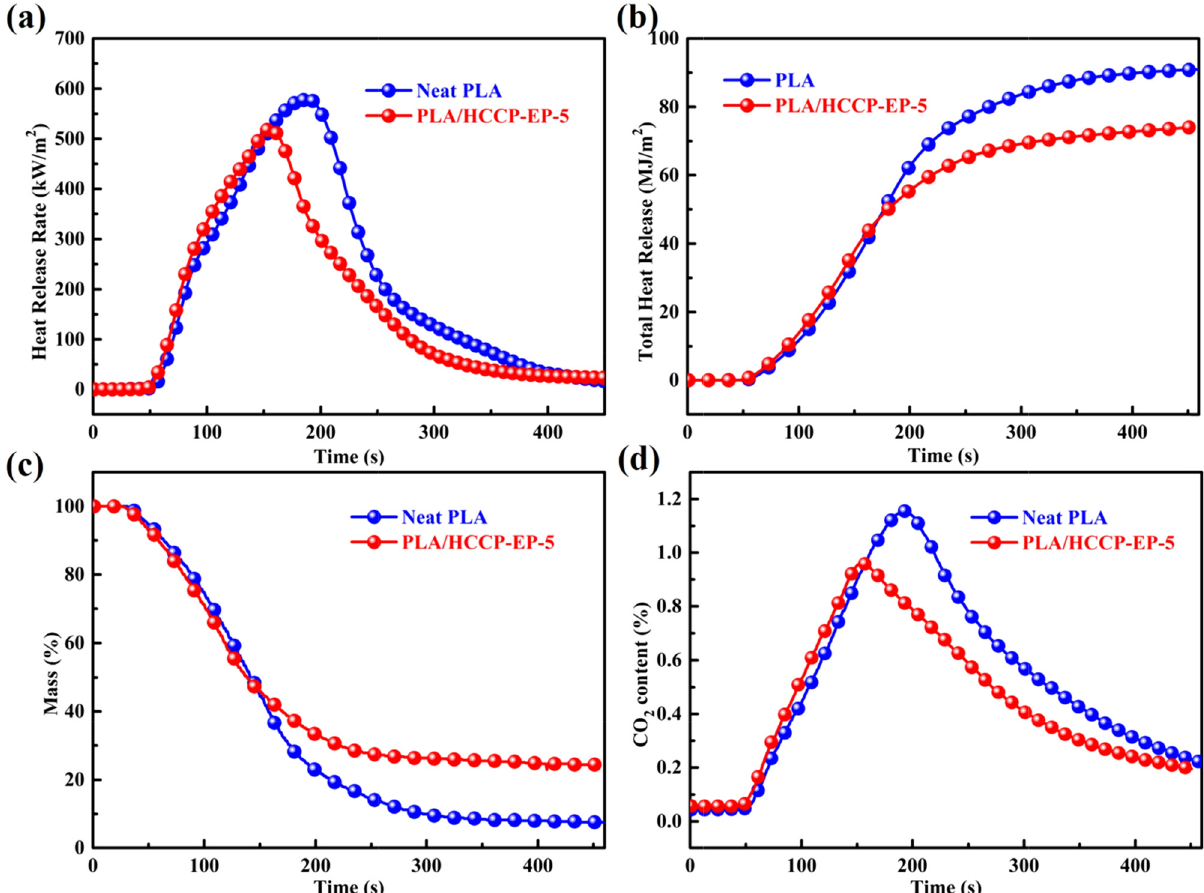
Figure 6: Fire safety performance of PLA and PLA/HCCP - EP - 5 obtained from CCT. ( a ) HRR, ( b ) THR, ( c ) RM, and ( d ) CO 2 content ( CO 2 Y ) .